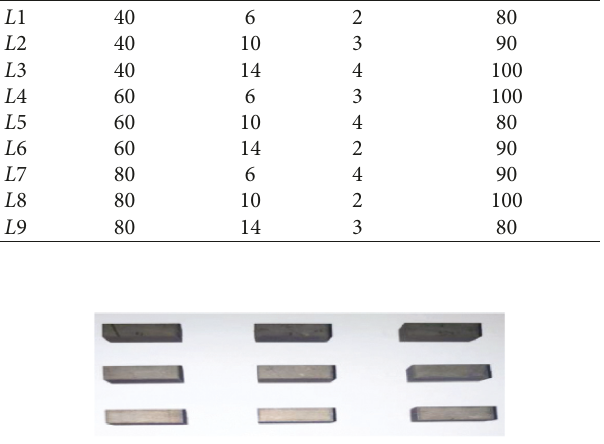
Figure 1: Wire EDM machined